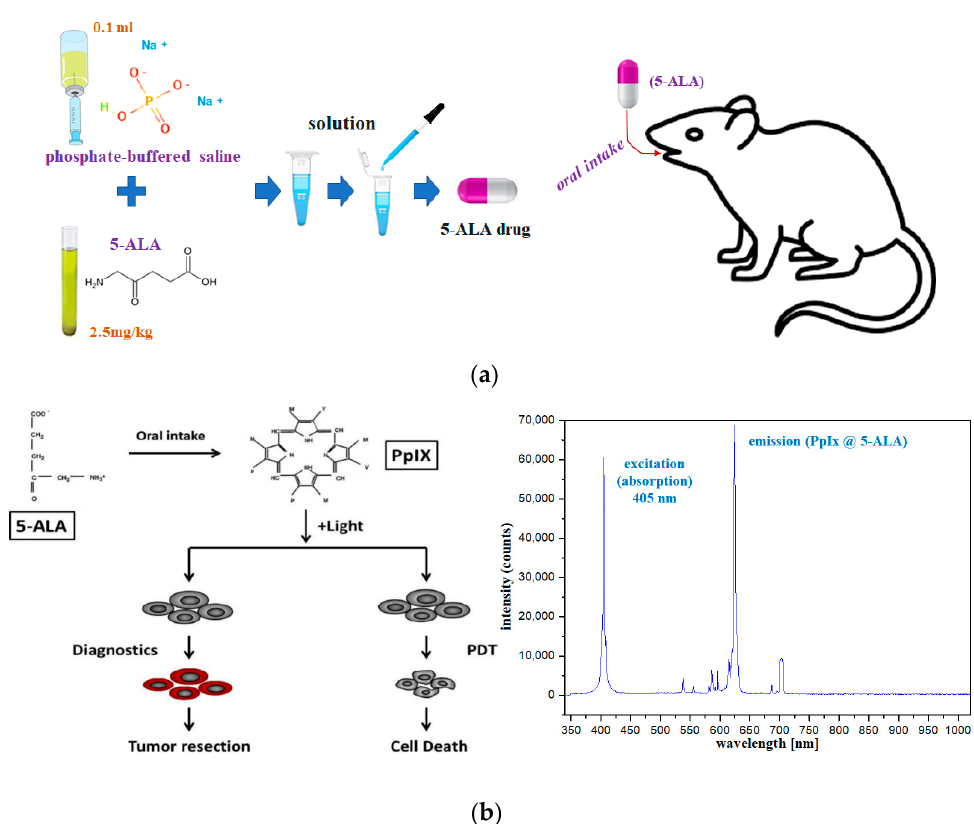
Figure 6. 5-ALA fluorescence contrast process. ( a ) process of injection, ( b ) molecular structure of plasma protein binding by 5-ALA injection.